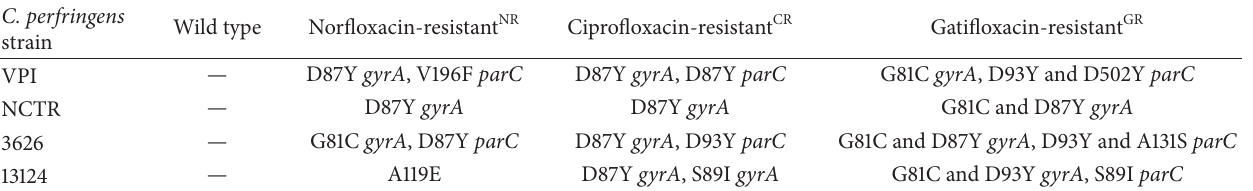
Table 1: Wild types and fluoroquinolone-resistant mutants of C. perfringens used in this study with stable mutations in gyrA and parC resulting in amino acid